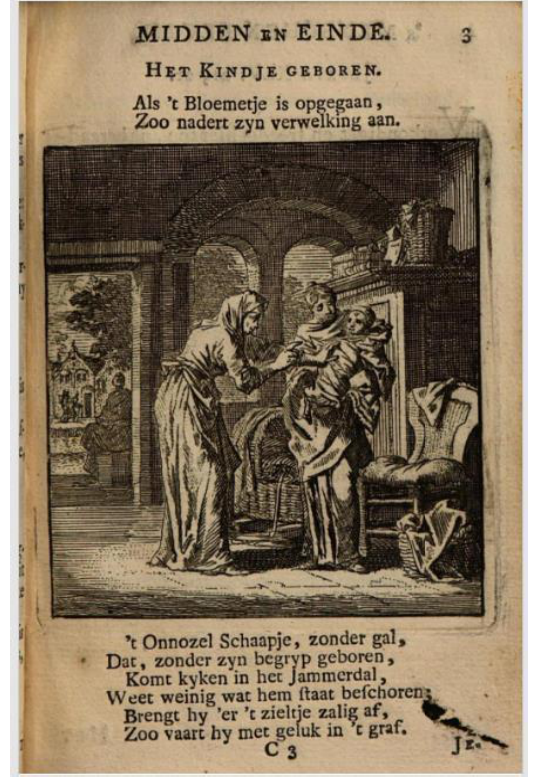
Figure 15. Jan Luyken, “Het Kindje Geboren.”